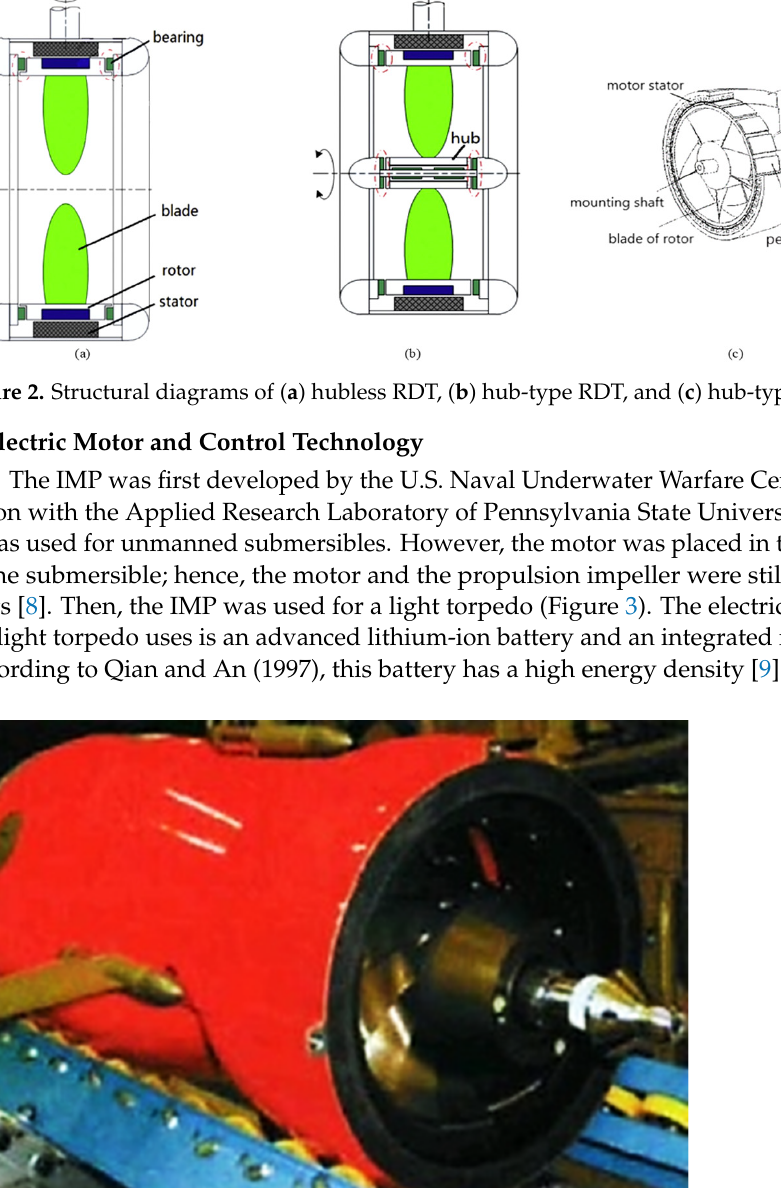
Figure 3. Prototype of integrated motor propulsion developed by the U.S. Navy [8].